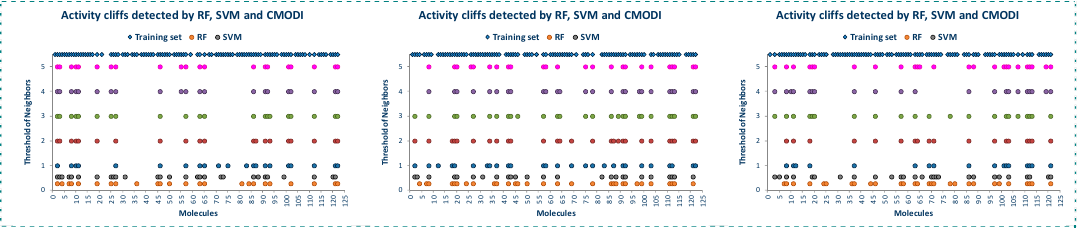
Figure 9. False positive/negative detected by RF and SVM algorithms and CMODI for the training sets in the three external validations carried out.